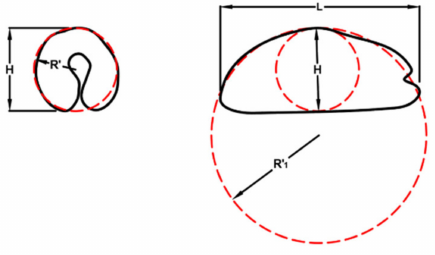
Figure 11. Estimation of the radii of curvature of wheat grain